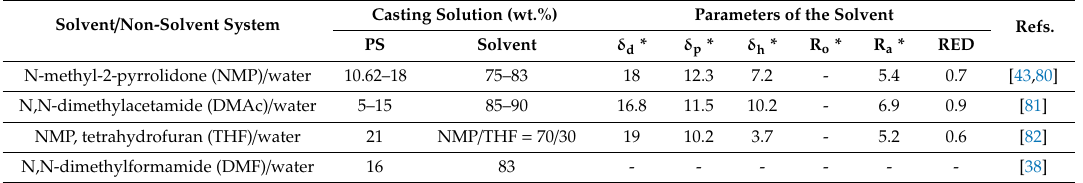
NMP, tetrahydrofuran (THF) /